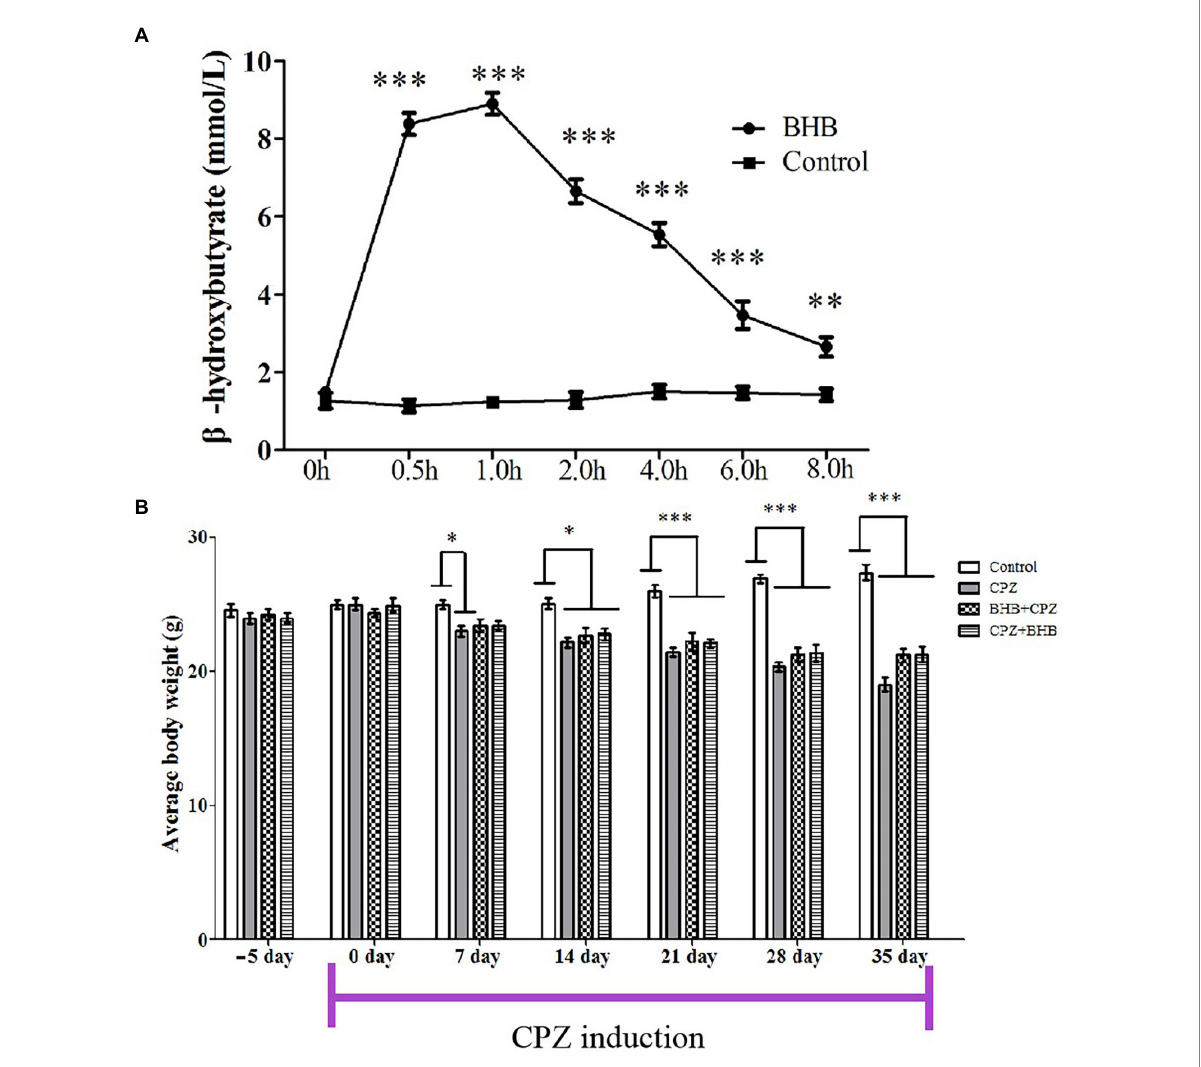
FIGURE 2 Dose–response curves of blood β -hydroxybutyrate concentrations after intraperitoneal injection of BHB (A) and average body weights of mice at each experimental time point (B) . N = 10 mice/group. The data were presented as mean. * p < 0.05, ** p < 0.01 and *** p < 0.001 versus the control